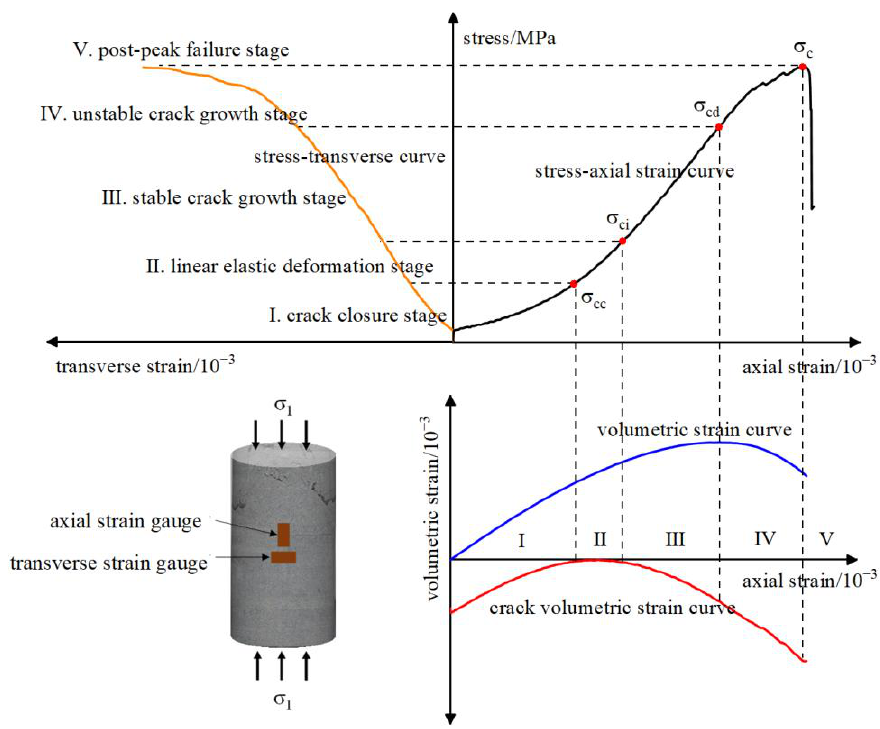
Figure 4. Division of rock characteristic stress stages.